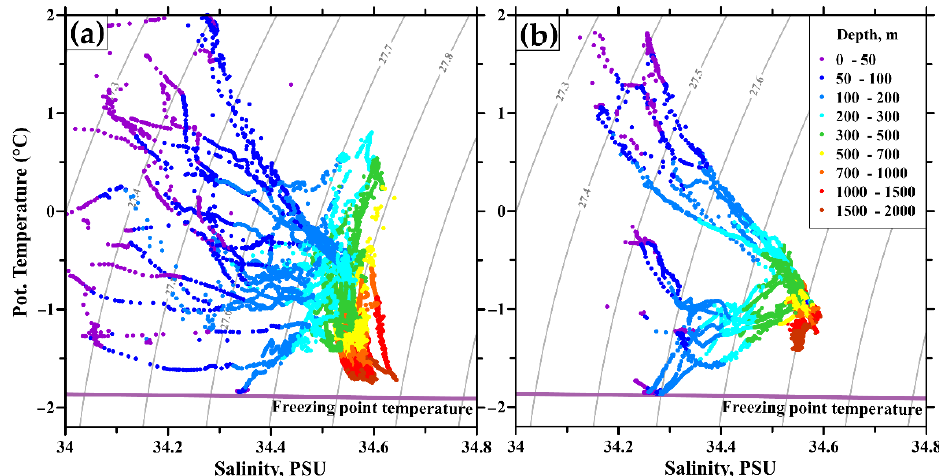
Figure 9. Temperature–salinity diagrams including the freezing-point temperature (magenta line) and sigma contours (gray lines) at the available hydrographic stations in the WOD2018 database for the ( a ) central and ( b ) eastern basins. Only full-depth profiles deeper than 1500 m were selected from the database. The colors of the dots indicate depths of measurements; see color scale in ( b ). The freezing-point temperature was calculated on the basis of EOS80 equations [44].